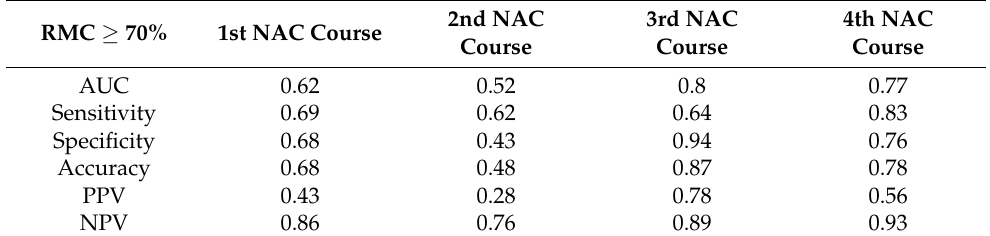
Figure 8. AUC values determined for the examined classifiers as a function of chemotherapy courses for two thresholds: RMC ≤ 30% and RMC ≥ 70%. Table 5. Combined model for changes in echogenicity and volume after individual NAC courses for RMC ≥